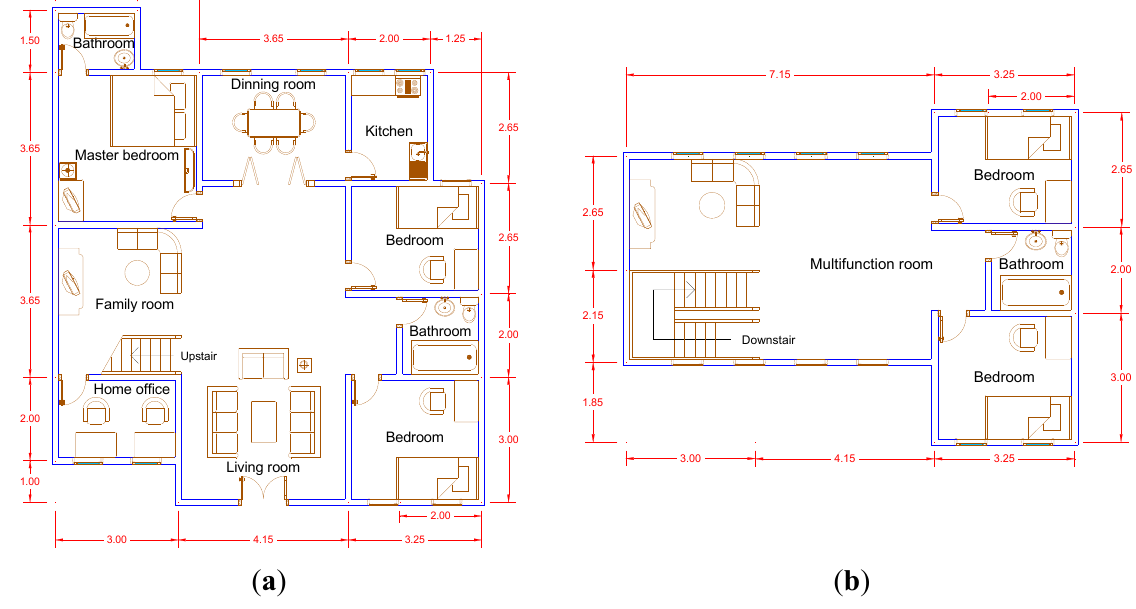
Figure 1. Floor plans of the main simulation target (not to scale) (unit: m). ( a ) First floor plans; ( b ) second floor plans